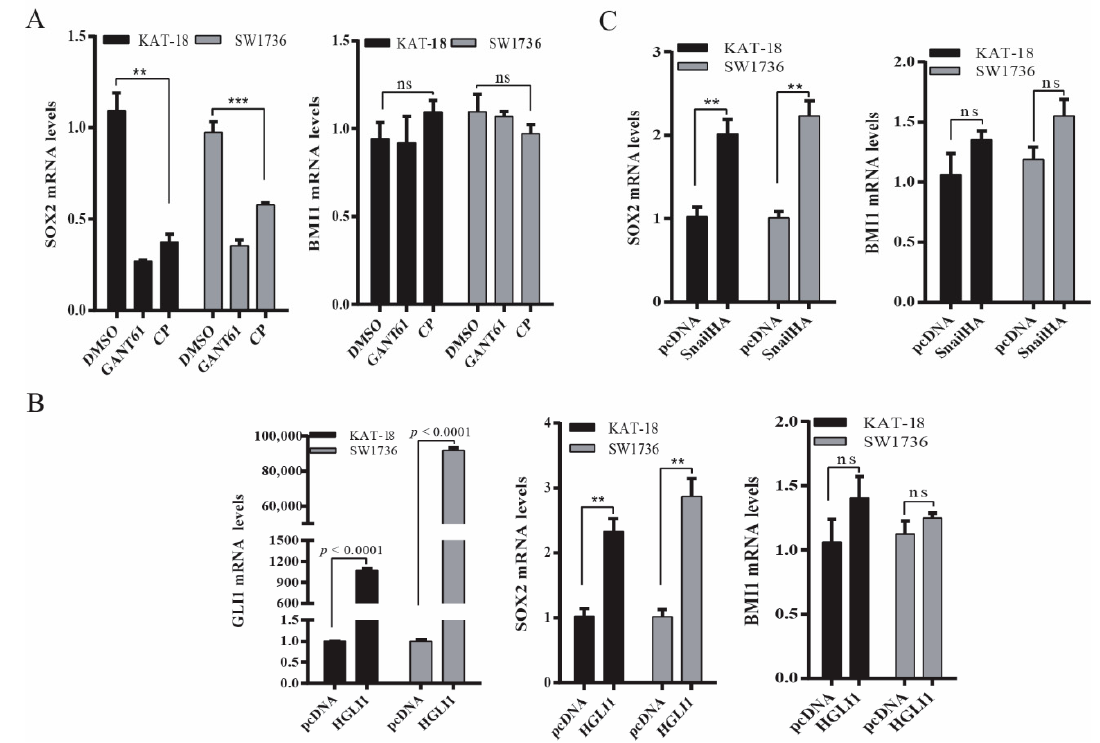
Figure 3. The Shh pathway regulated SOX2 and BMI1 mRNA expression. ( A ) KAT ‐ 18 and SW1736 cells were incubated for 48 h in the absence or presence of GANT61 (10 μ M) or cyclopamine (10 μ M) for 48 h. ( B ) KAT ‐ 18 and SW1736 cells were transfected with the empty expression vector or the vector encoding Gli1 ( B ) or Snail ( C ). After incubation for 48 h, total RNA was extracted and analyzed for SOX2, BMI1, and Gli1 mRNA levels by RT ‐ PCR. GAPDH was included as an internal control. Data represent the results of mean ± SD of three independent experiments. * p < 0.05; ** p < 0.01; *** p < 0.001, ns: not significant when compared to the control.